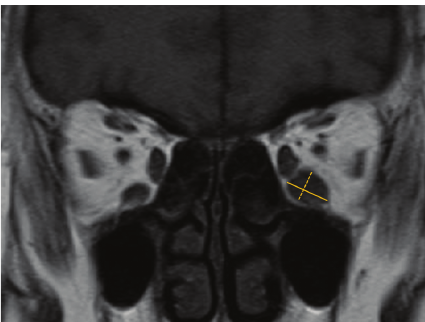
Figure1:Measurementofthethicknessoftheinferiorrectusmuscle (IRM). The major axis of the IRM (solid line) and the minor axis perpendicularly crossing the major axis on the surgical side (dotted line) are measured on the T1-weighted coronal magnetic resonance image showing the largest IRM cross-sectional